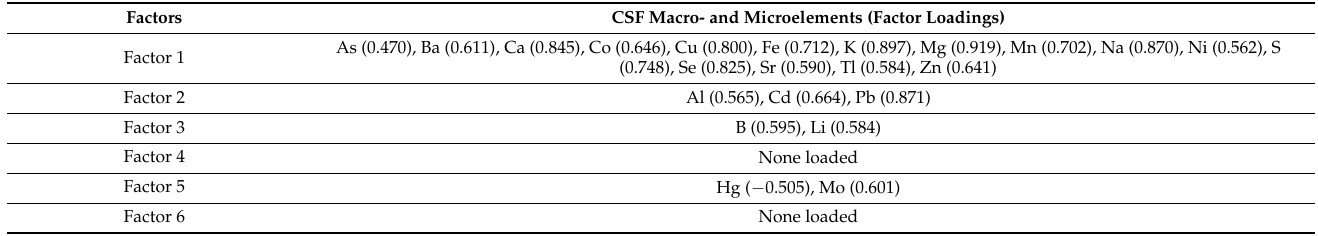
Table 2. CSF macro- and microelements and their factor loadings for 6 groups (factors) (given by the PCA).